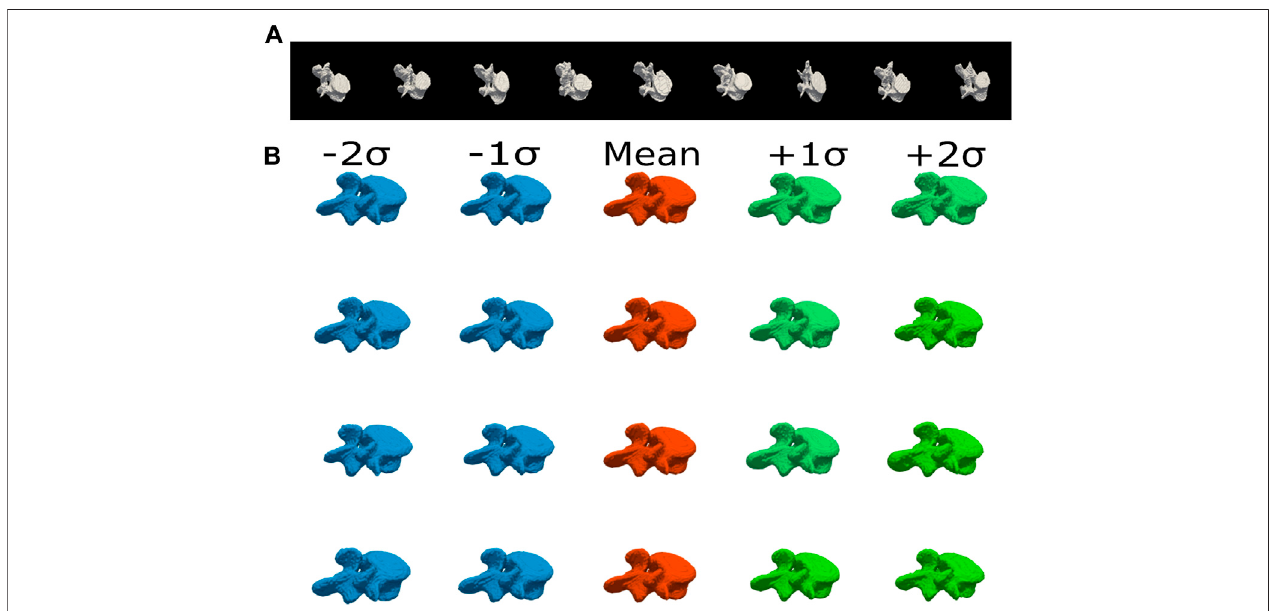
FIGURE 4 | (A) Sample gold standard volumes comprising the training set of groundtruth segmentations of L4 vertebra, with subtle differences in shape. This is a representative database, with variations in the vertebral processes and in the thickness of the vertebral bodies. (B) Shape Variations. The fi rst four eigenshapes are depictedwiththe fi rstandsecondnegativeandpositiveshapevariationsobtainedby ϕ ± σ i λ i ϕ i .Eachrowdepictsoneeigenshape.Lefttoright:ineachrow,onecansee how the eigenshape changes. There is a visible change in the structure of the vertebral processes. Top to bottom: there are clear visible differences amongst the different eigenshapes, especially in the vertebral